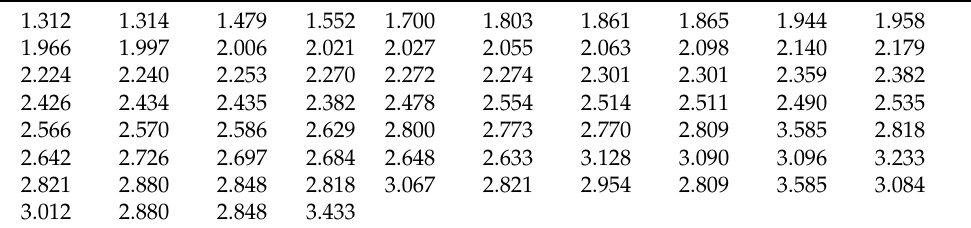
Table 12. The observations of gauge lengths of 20 mm data.